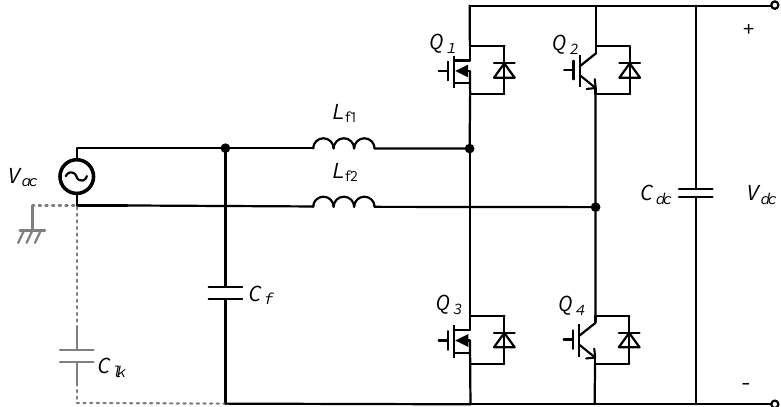
Figure 2. Configuration of PFC topology.